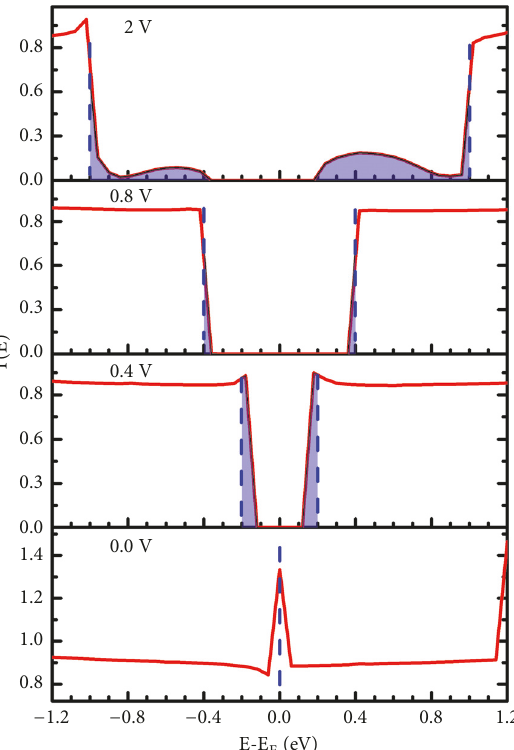
Figure 8: Transmission spectraof 8-DZGNR atdifferent bias voltages ( △ V = 0.0 V, 0.4 V, 0.8 V, and 2.0 V). The verticaldashed lines represent the bias windows.